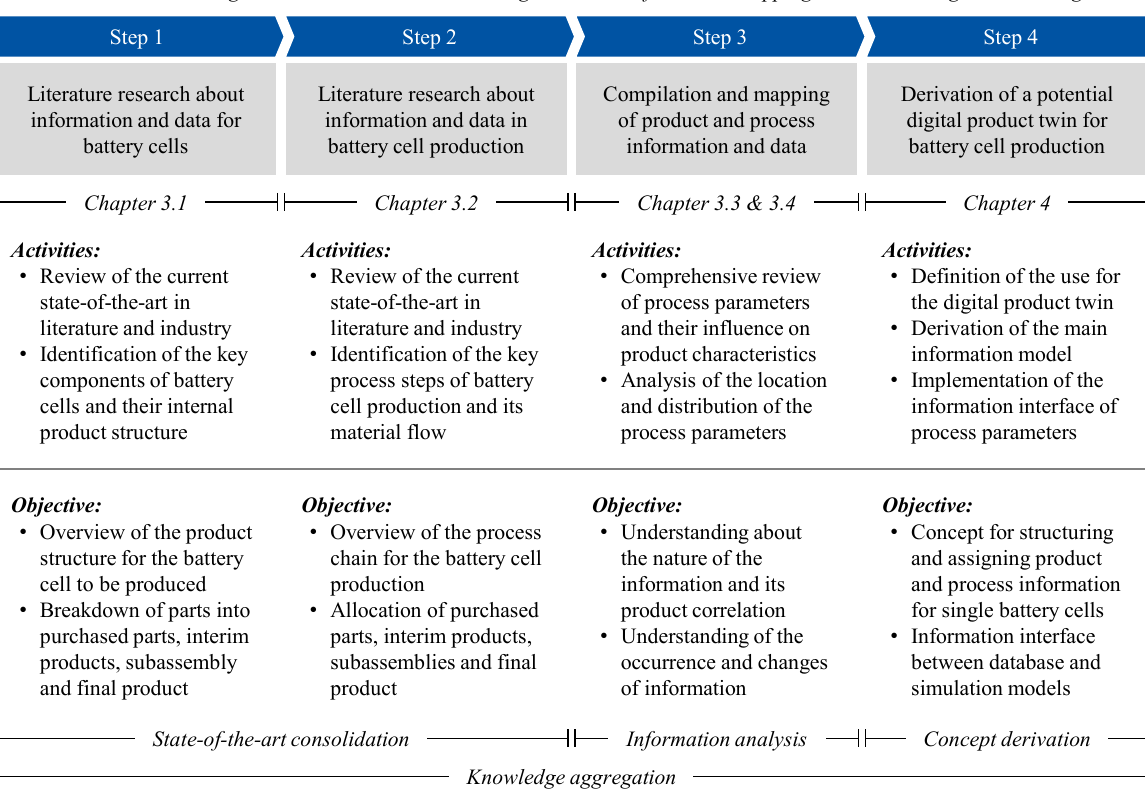
Figure 2. Approach for the derivation of a digital product twin in ba tt ery cell production.